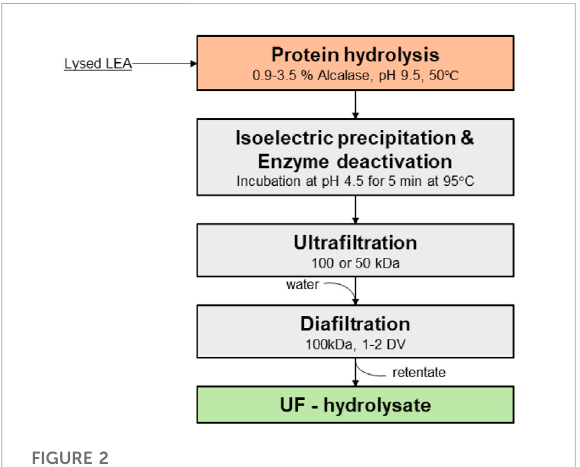
FIGURE 2 Flow diagram of the process for the production of UF-